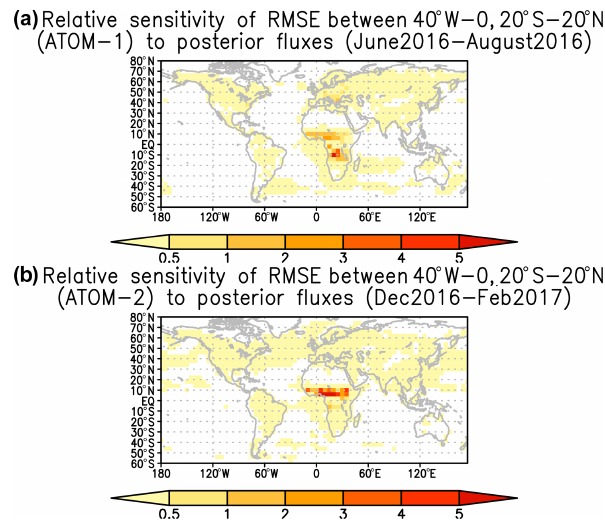
Figure B8. The relative sensitivity of RMSE of posterior CO 2 to NBE over land and air–sea net carbon exchange over ocean at every grid point. The RMSE is calculated against aircraft CO 2 observations from ATom 1 (a) and ATom 2 (b) between 40 ◦ W–0 ◦ , 20 ◦ S–20 ◦ N. The adjoint model is carried out over June–August 2016 (a) and December 2016–February 2017 (b) . Unit: %.